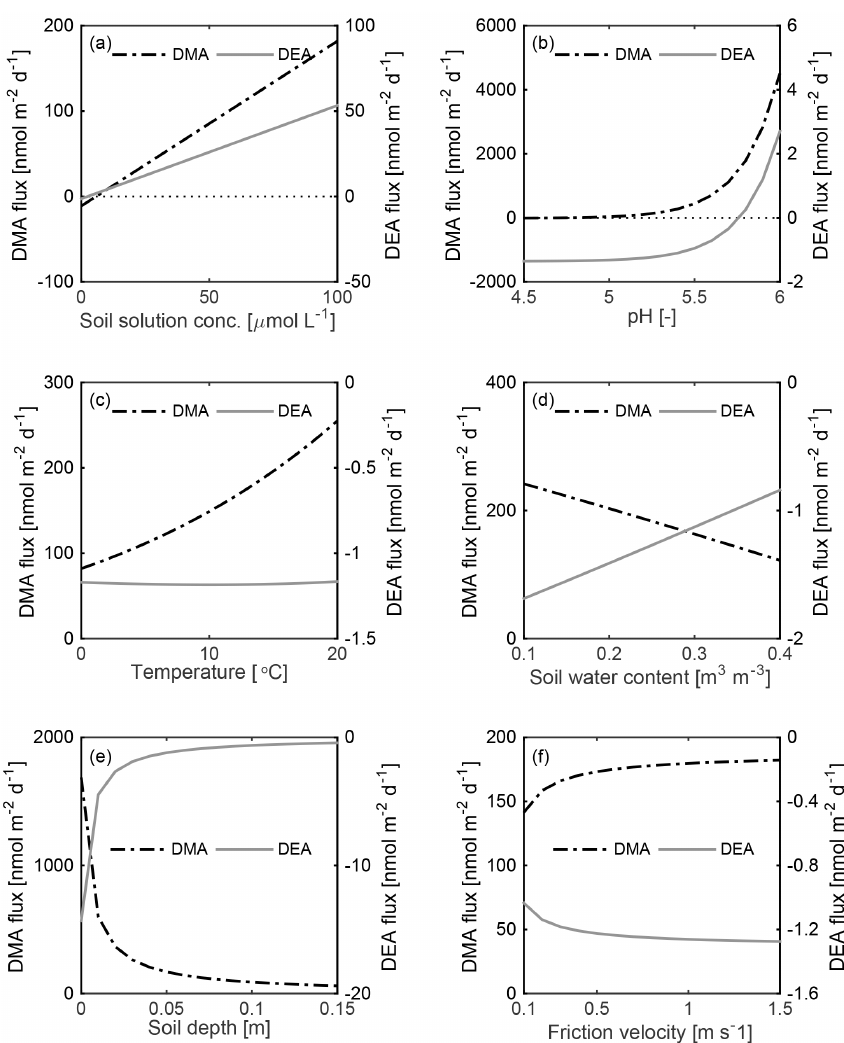
Figure 6. Effect of soil solution concentration (a) , soil pH (b) , temperature (c) , soil water content (d) , organic soil depth (e) , and above- canopy friction velocity (f) on soil flux estimates of dimethylamine (DMA) and diethylamine